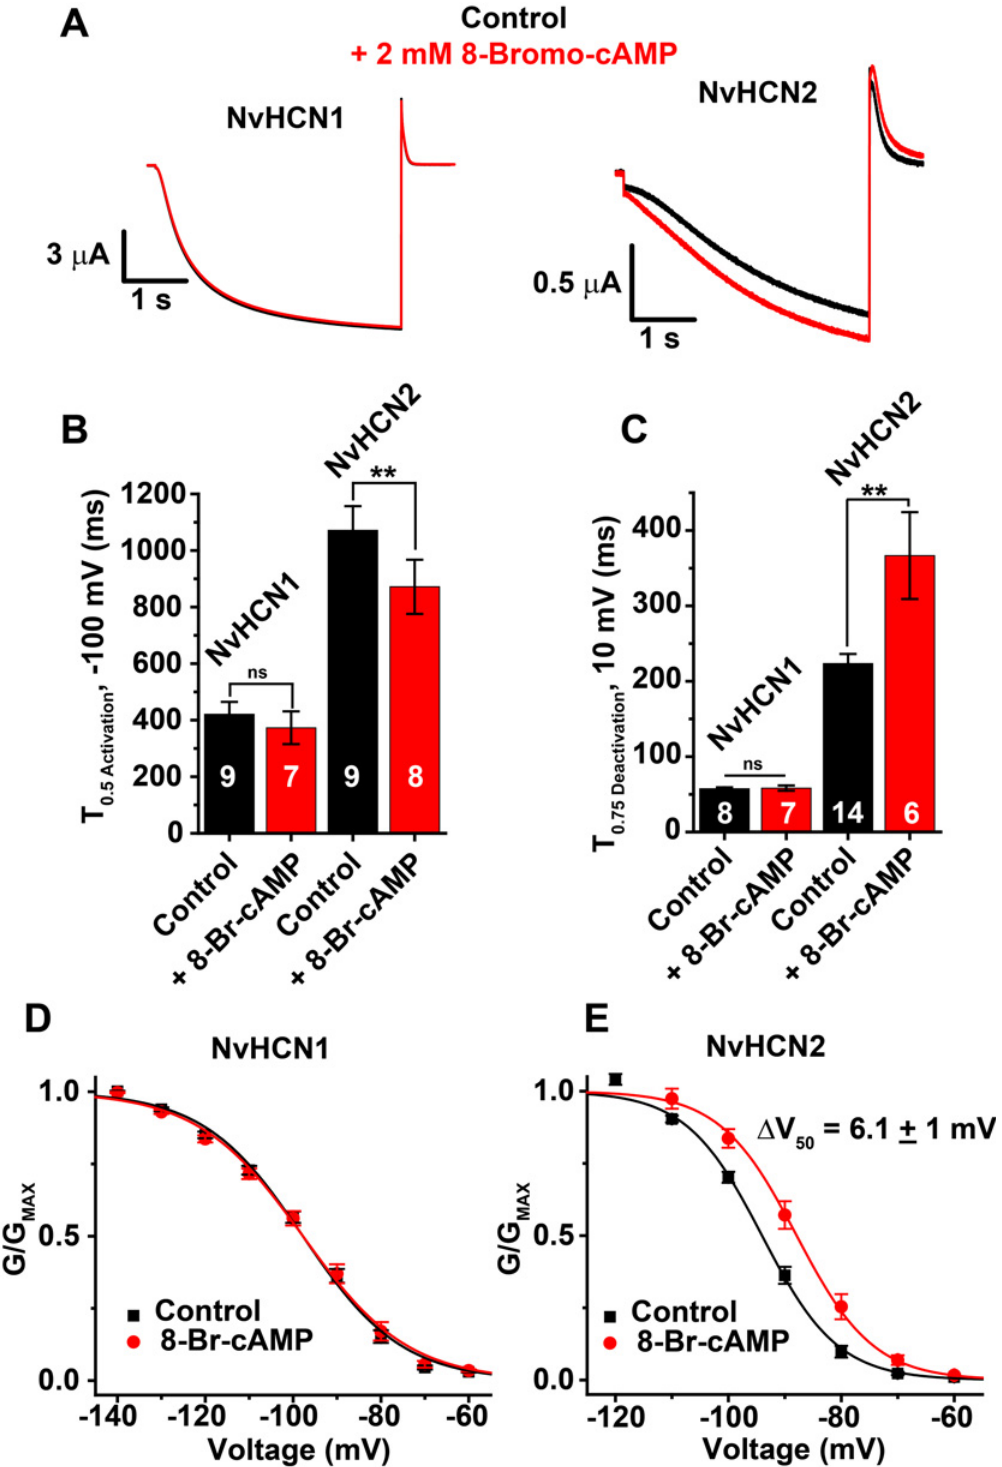
Fig 5. 8-Br-cAMP enhances activation of NvHCN2 but not NvHCN1. (A) Examples of currents recorded in response to 4 s -100 mV voltage steps before (black) and after (red) bath application of 2 mM 8-Br-cAMP (-30 mV holding potential, tails recorded at 0 mV). (B) Half activation times at -100 mV for NvHCN1 and NvHCN2 before (black) and after (red) the addition of 2 mM 8-Br-cAMP. (C) 75% deactivation time at 10 mV for NvHCN1 and NvHCN2 with (red) and without (black) 2 mM 8-Br-cAMP. (D,E) GV curves for NvHCN1 and NvHCN2 with (red) and without (black) 2 mM 8-Br-cAMP. All data